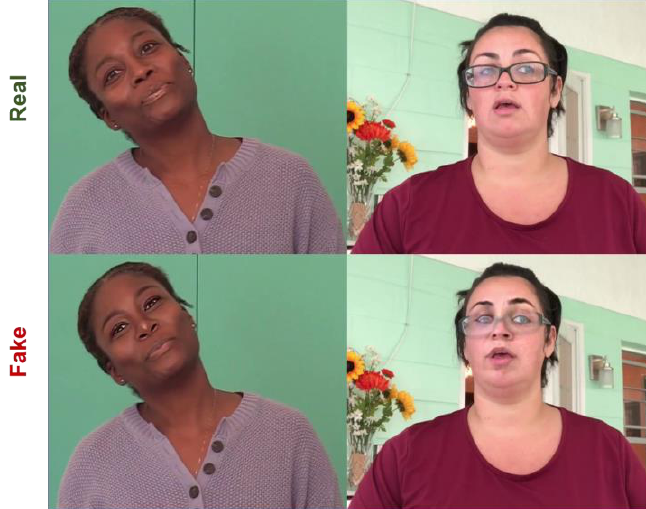
Figure 1. Photo-realistic deepfake images that exist in real life.